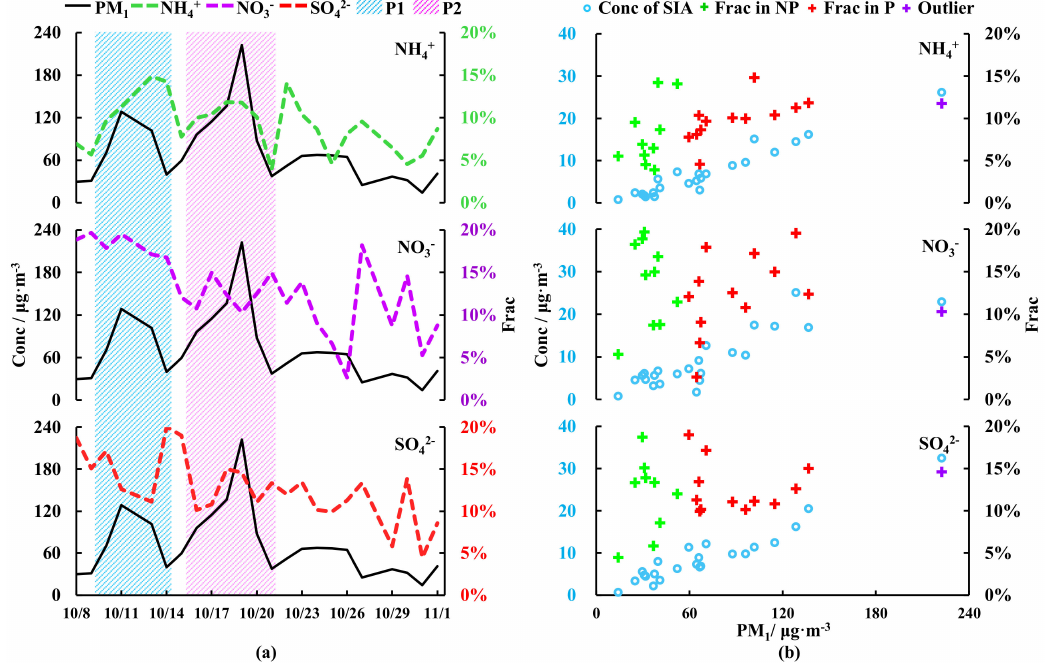
Figure 6. Variations in the concentrations and fractions of secondary inorganic aerosol (SIA) (conc: concentration; frac: fraction). ( a ) The time series of SIA mass fractions related to PM 1 concentration; ( b ) the scatter plot of mass concentration and fractions of SIA as a function of PM 1